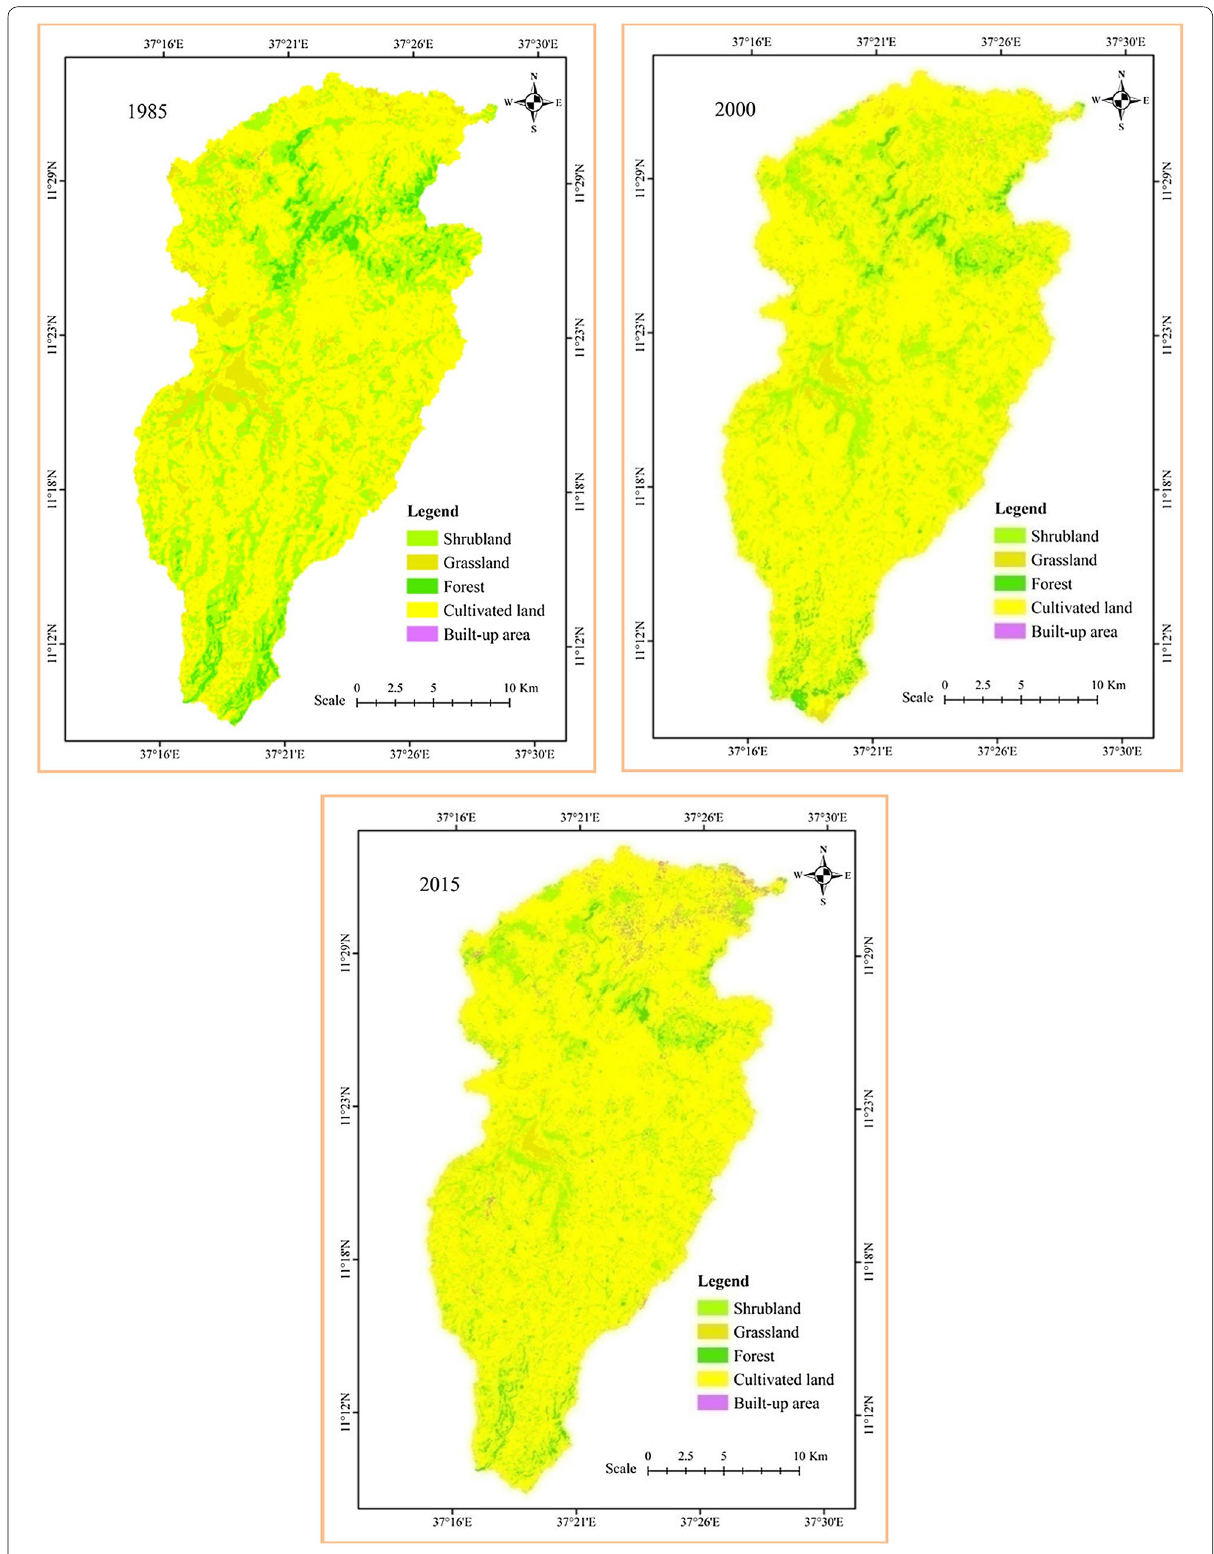
Fig. 3 Land use/cover of 1985, 2000 and 2015 of the Andassa